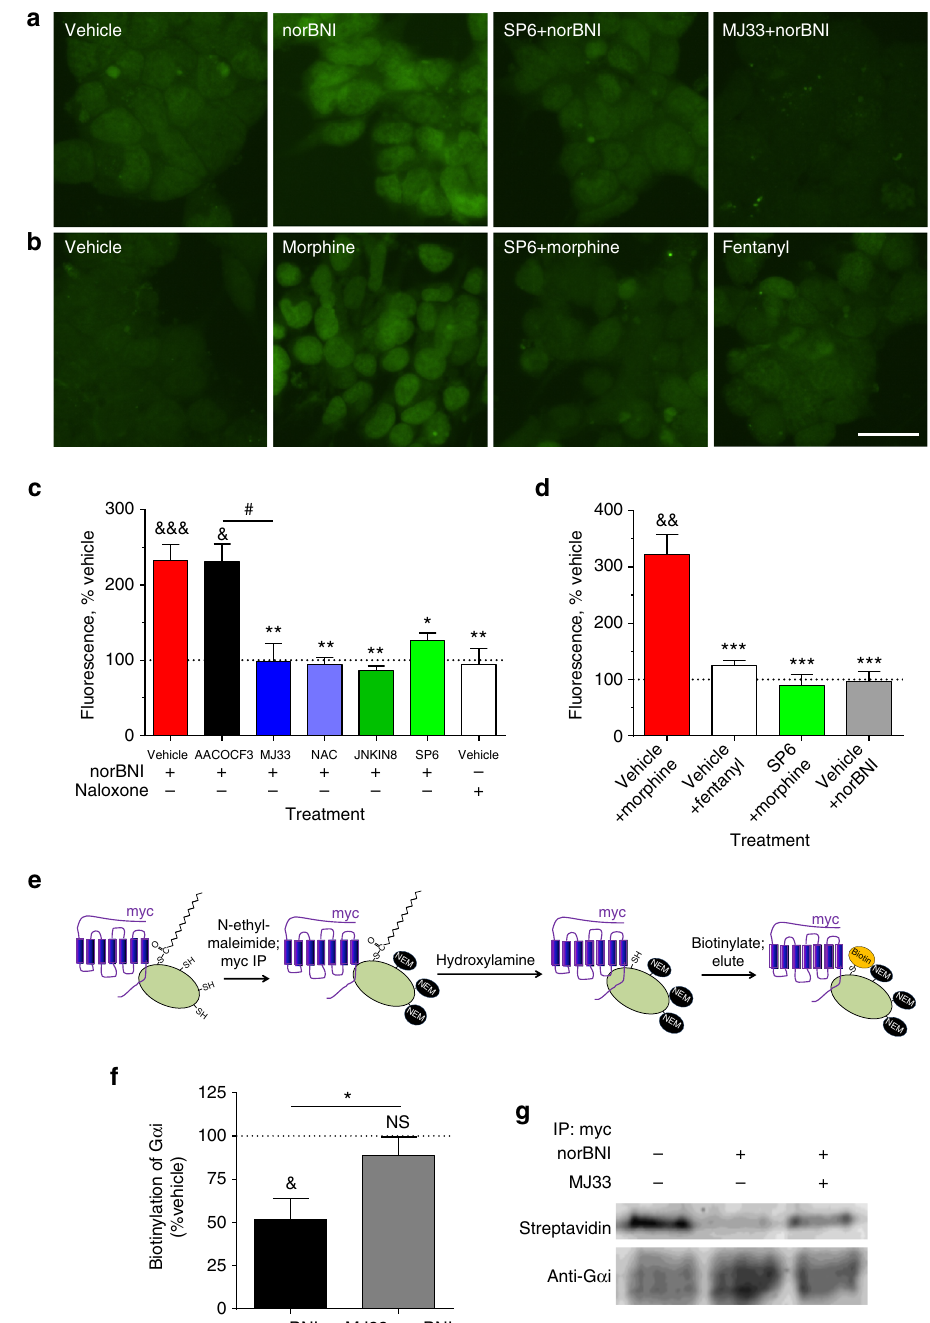
Fig. 3 NorBNI and morphine induce ROS production via JNK and PRDX6. MycKOR a , c or mycMOR b , d expressing HEK293 cells were pretreated with vehicle, AACOCF3 (10 µ M), JNK-IN-8 (1 µ M), SP610025 (1 µ M), MJ33 (10 µ M), or N-acetyl-cysteine (NAC, 10 µ M) 30 min prior to being treated for 1 h with norBNI (10 µ M), morphine (10 µ M), fentanyl (10 µ M) or naloxone (10 µ M). a , b Cells were imaged for ROS using CellROX Green; scale bar